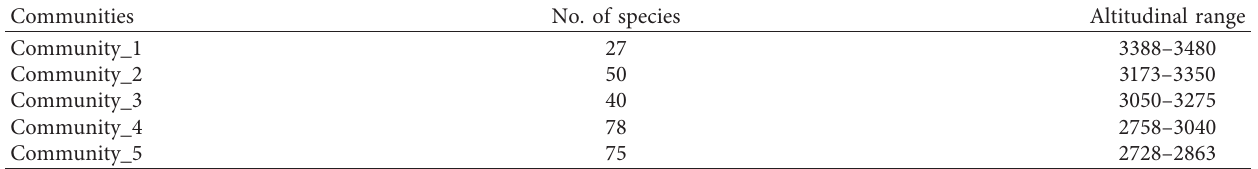
Table 3: Species richness among the five plant communities in Gole